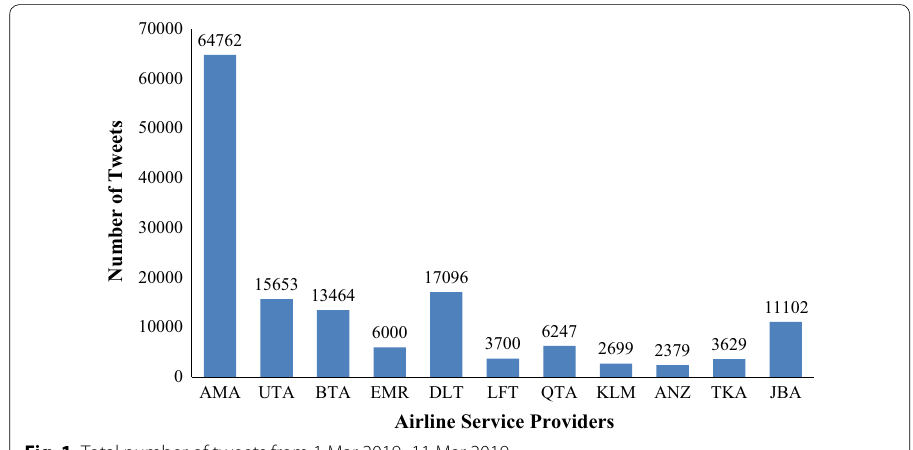
Fig. 1 Total number of tweets from 1 Mar 2019–11 Mar 2019